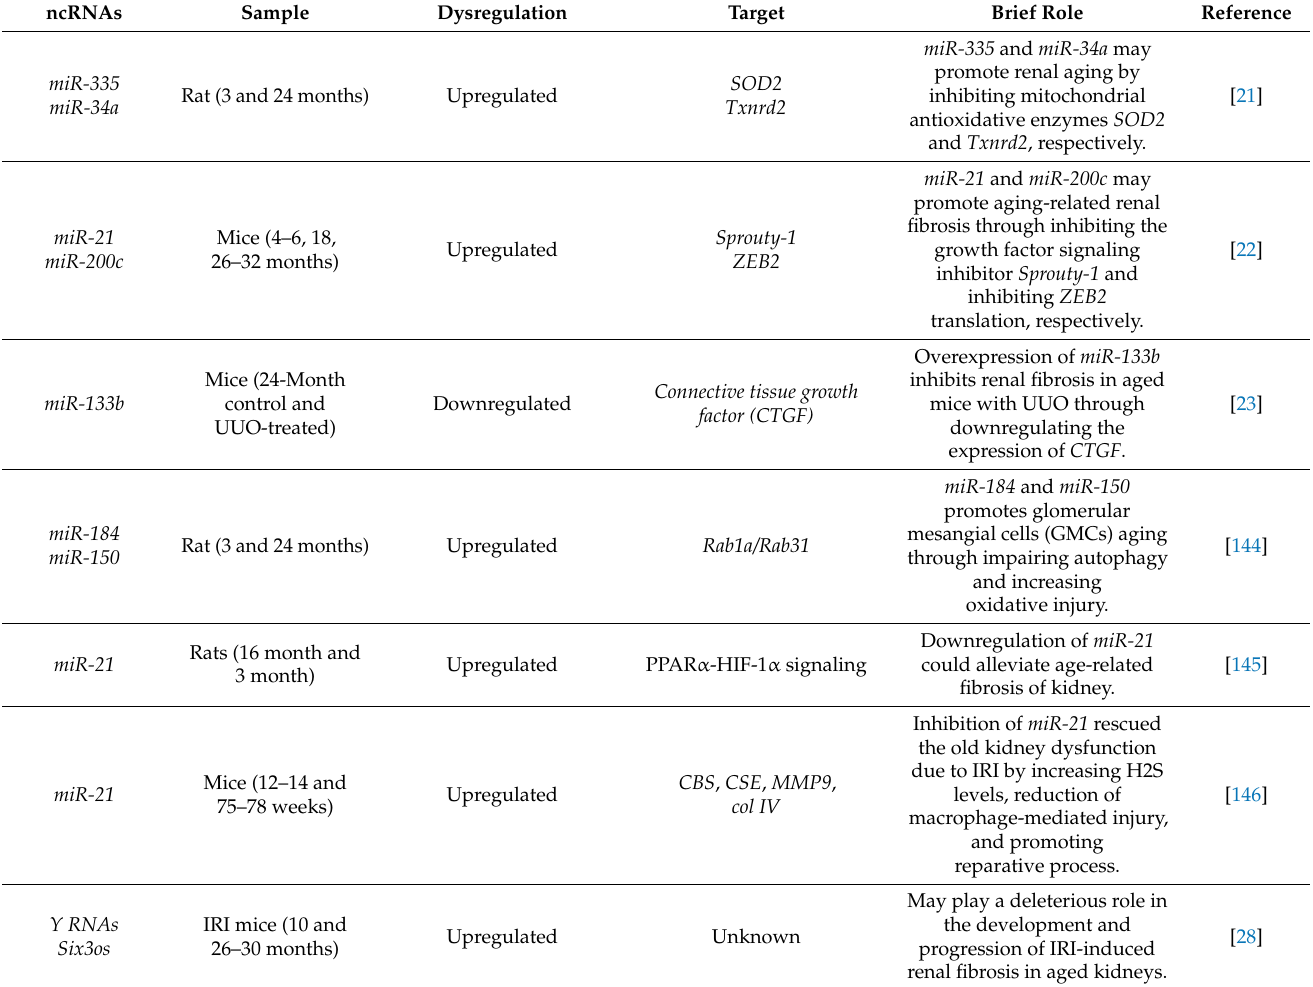
Table 3. Non-coding RNAs in age-related kidney